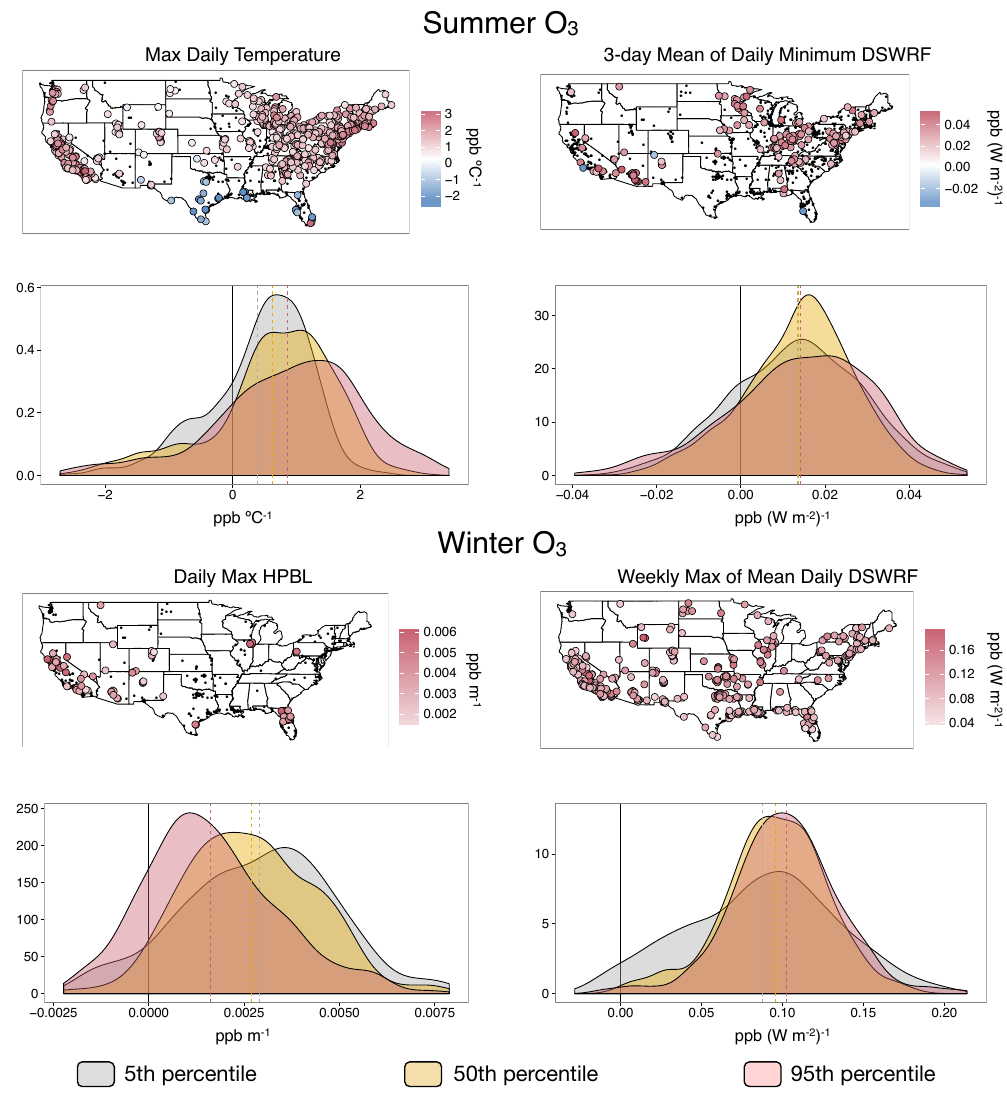
Figure 6. Spatial and frequency distributions for key covariates of summer (top panels) and winter (bottom panels) O 3 . Maps show 95th per- centile O 3 sensitivities to selected meteorological variables at stations where that variable was most important (defined as being one of the top two normalized covariates). Below each map, histograms show the distribution of sensitivities for the 5th (gray), 50th (yellow), and 95th (red) percentiles at all